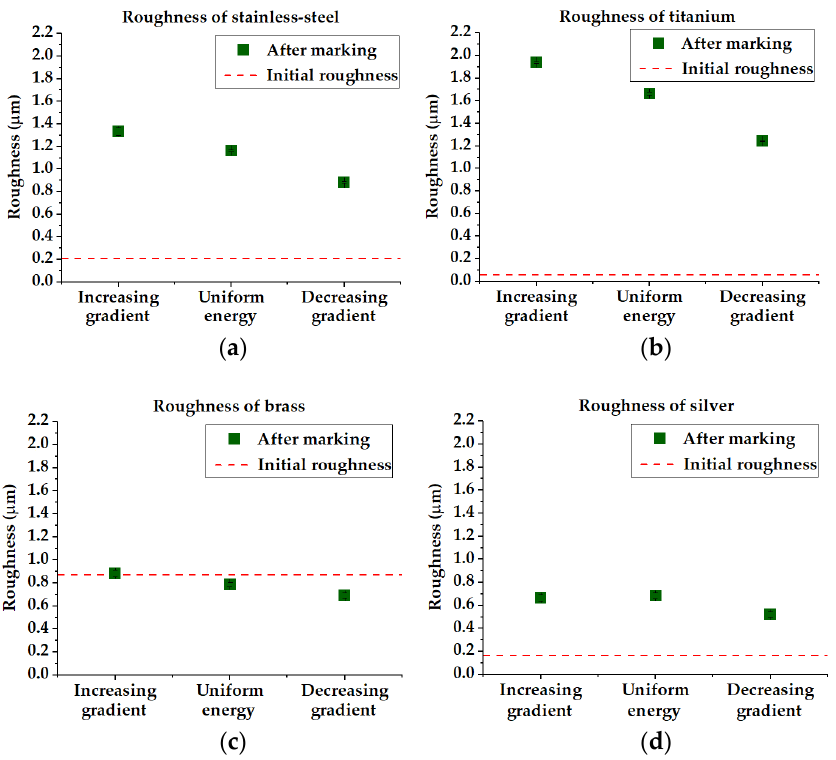
Figure 5. Roughness R a of ( a ) stainless steel, ( b ) titanium, ( c ) brass and ( d ) silver. The roughness data after laser patterning are plotted with the initial roughness. Steel, titanium and silver exhibit an increase in roughness post-irradiation, whereas brass keeps nearly the same level of roughness. In the cases of steel, titanium and brass, the highest value of roughness is obtained with an ascending energy gradient (fluences from 0.5 to 9.5 J/cm 2 ) and reaches the lowest value with a descending energy gradient (fluences from 9.5 to 0.5 J/cm 2 ). In the case of silver, the roughness with an increasing energy gradient is slightly lower than in the case of uniform energy.